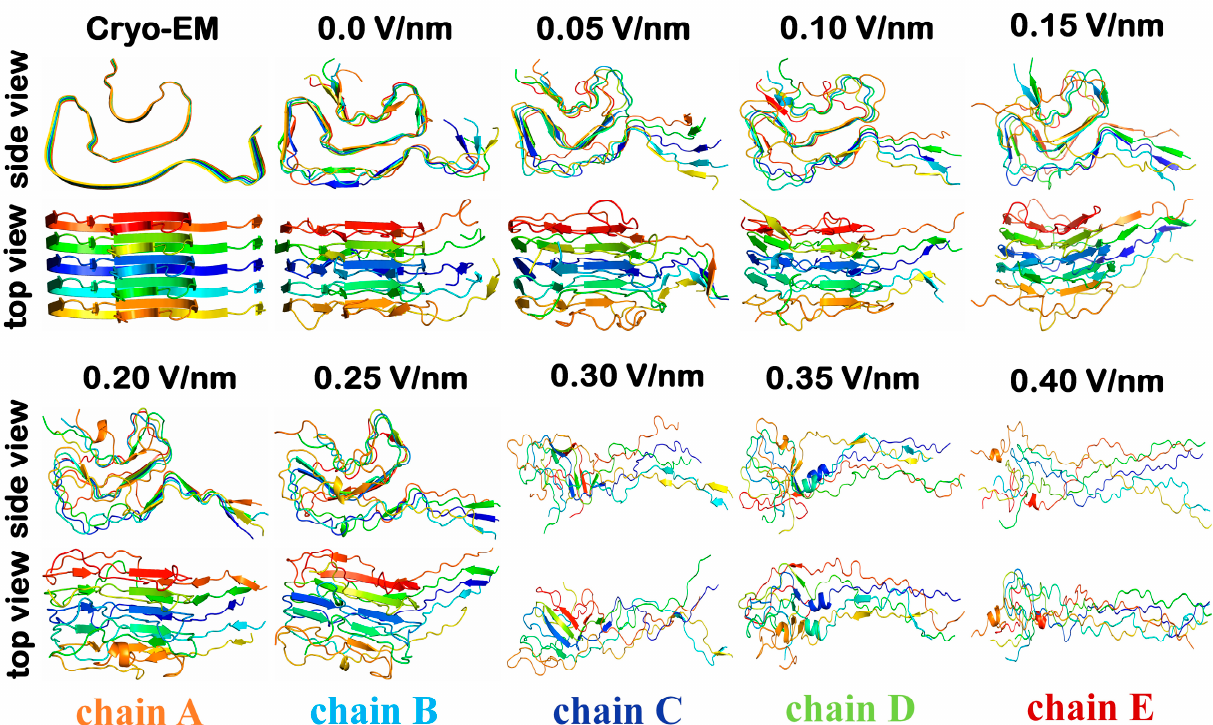
Figure 1. The last snapshots of α -synuclein pentamers which were extracted from the 600 ns MD trajectory. The side and top view show conformational changes on α -synuclein under the influence of 0.05, 0.10, 0.15, 0.20, 0.25, 0.30, 035, and 0.40 V/nm electric fi eld.